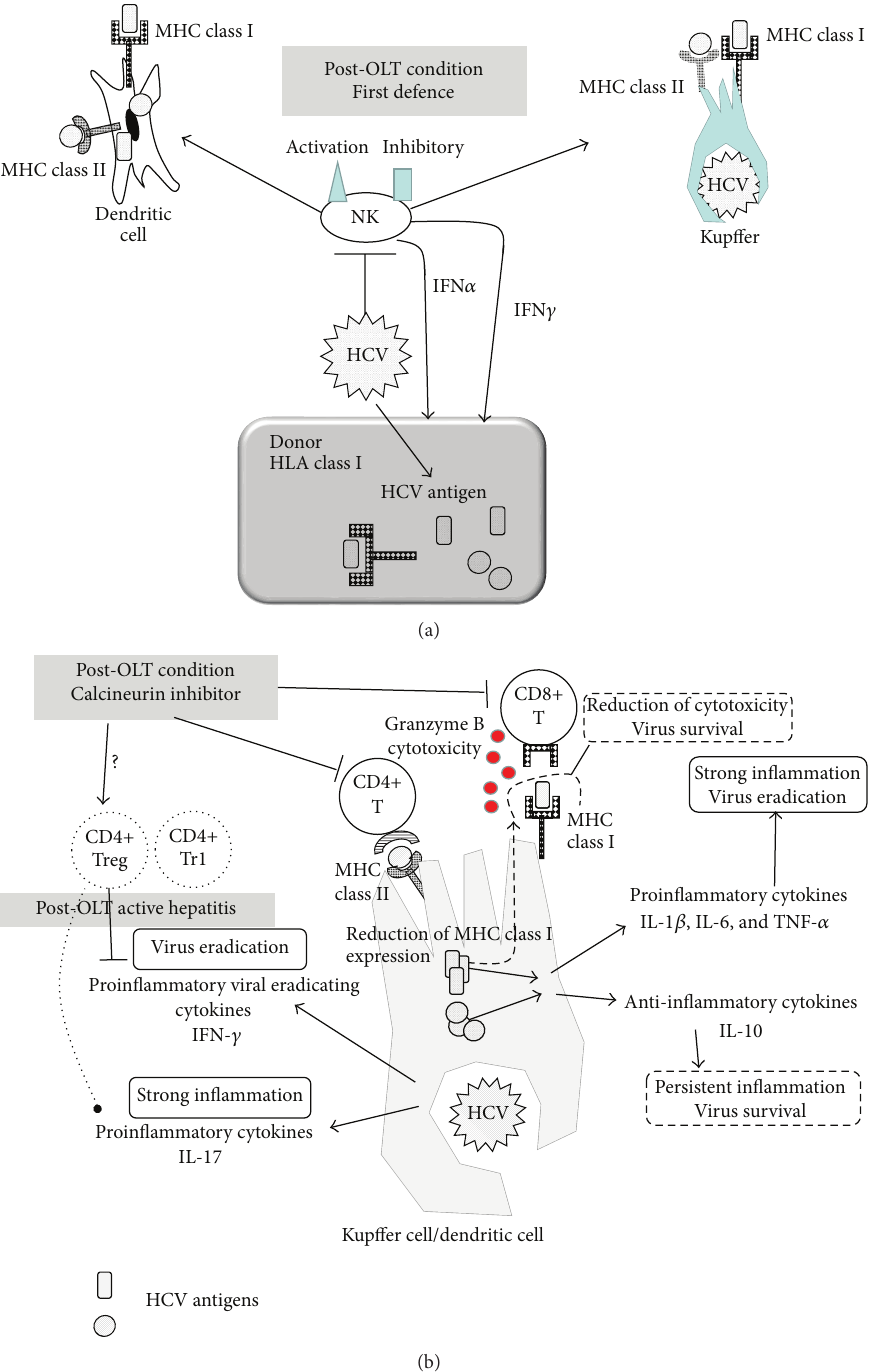
Figure 1: Immune status in chronic hepatitis C and postorthotopic liver transplantation (OLT) hepatitis C. (a) NK cells are the first immunological defense system from hepatitis C virus (HCV). The phenotype defined with the activation or inhibitory receptor gene polymorphism affects the chronic hepatitis C activity and the post-OLT hepatitis activity. The interferon producing function is decreased by HCV proteins. (b) Kupffer cells or dendritic cells (DCs) have important roles in bridging innate and adaptive immune responses. These cells show proinflammatory and anti-inflammatory functions when infected with HCV. These cytokines’ balance is well controlled for viral persistence and chronic inflammatory state by viral antigens. After OLT, regulatory T cells might affect to reduce antiviral defence but not to reduce inflammatory cytokines resulting in severer chronic hepatitis. The type 1 regulatory T cells (Tr1) may induce severe hepatitis, while a lower frequency of Tr1 is correlated with hepatitis control with HCV positive status. NK: natural killer cell, OLT: orthotopic liver transplantation, HCV: hepatitis C virus, MHC: major histocompatibility complex, IFN: interferon, Treg: regulatory T cell, and Tr1: type 1 regulatory T